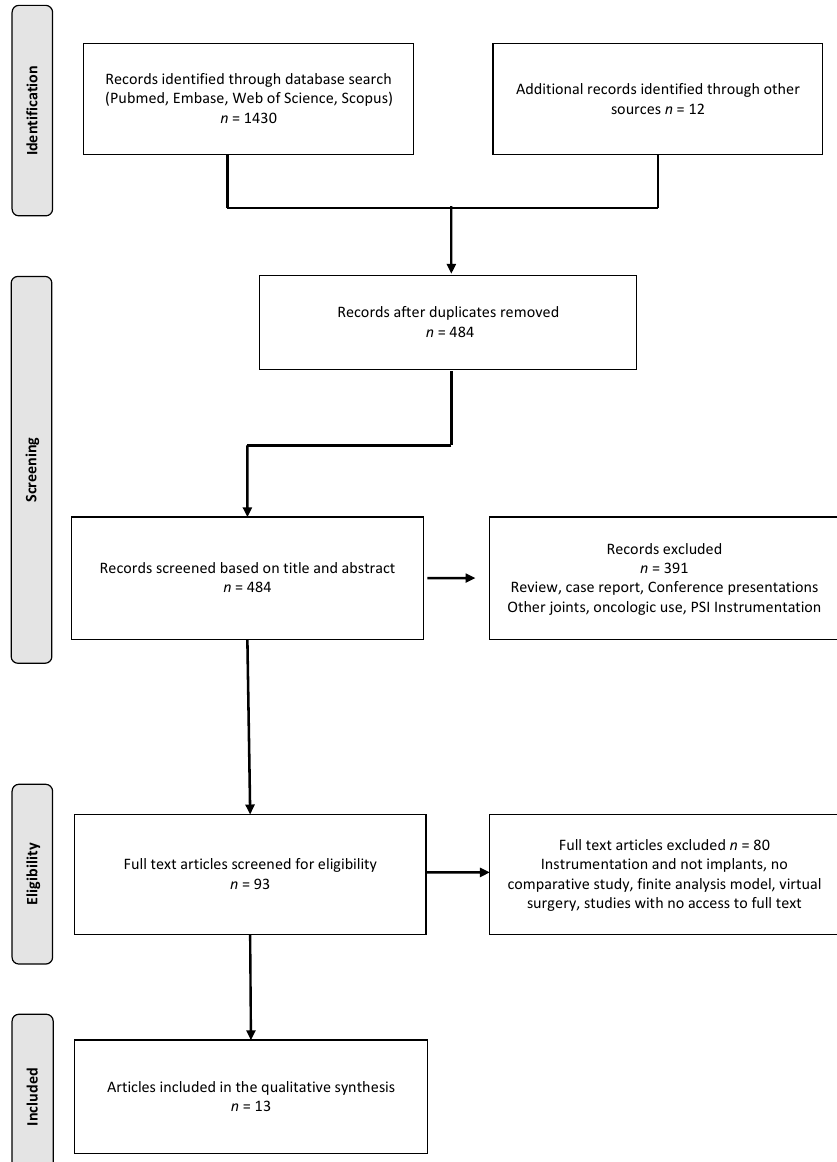
Figure 1. Flowchart of the study selection process according to the PRISMA Statement for the Conduct of Systematic Reviews.